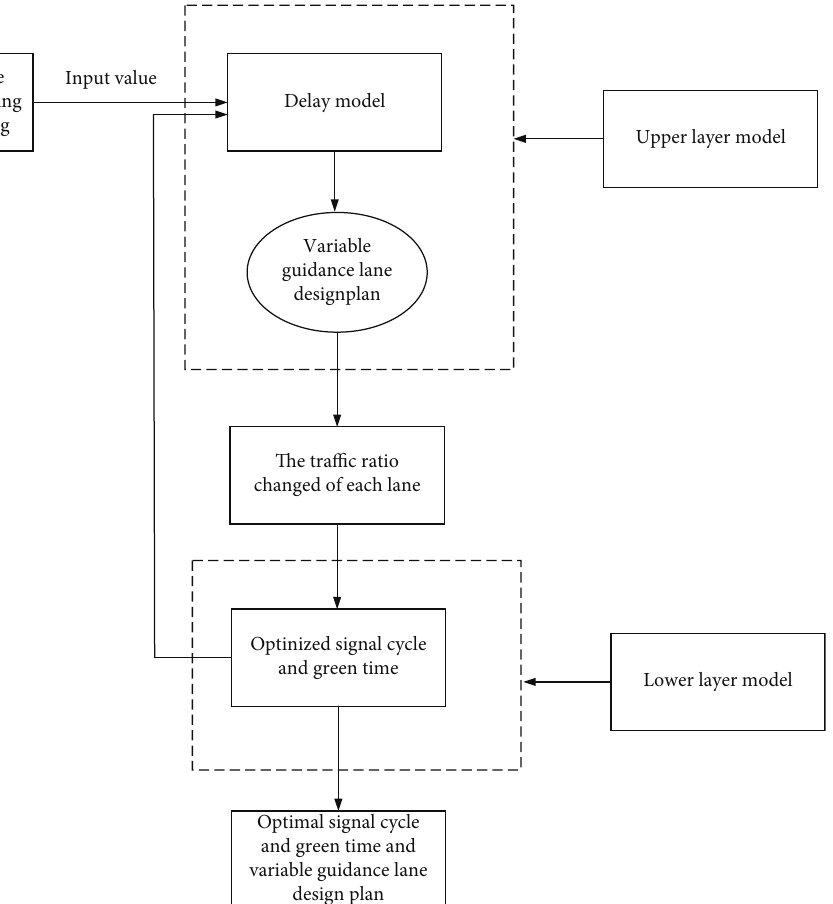
Figure 3: Detailed description of the model